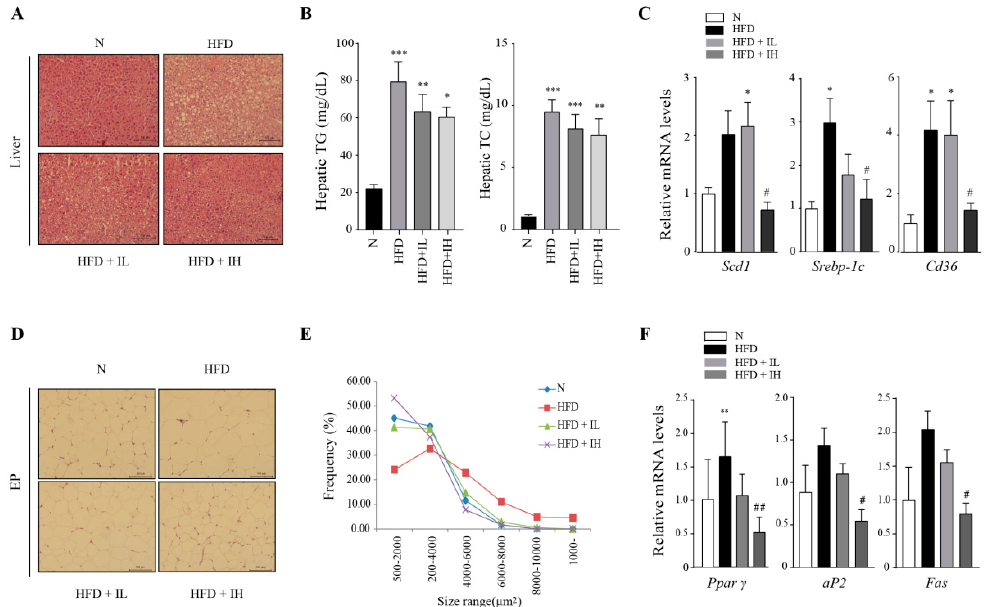
Figure 3. Effects of IJE on lipid accumulation in the liver and adipose tissue. ( A ) Images showing hematoxylin and eosin (H&E)-stained cross-sections of the liver (scale bar: 100 µ m). ( B ) Hepatic triglyceride (TG) and total cholesterol (TC) levels. ( C ) Relative mRNA levels of Scd1 , Srebp-1c, and Cd36 in the liver. ( D ) Images of H&E-stained cross-sections of epididymal fat pad (scale bar: 100 µ m). ( E ) Frequency of average cell size ( n = 3) in epididymal fat pad. ( F ) Relative mRNA levels of Ppar γ , aP2 , and Fas in epididymal fat pad. Data are presented as mean ± SEM. *, **, and *** indicate p < 0.05, 0.01, and 0.001, respectively, when compared to the N group. # indicates p < 0.05, whereas ## indicates p < 0.01 when compared to the HFD group. HFD, high-fat diet; HFD+IL, HFD+IJE 0.25% of diet; HFD+IH, HFD+IJE 0.5% of diet; N, normal diet.